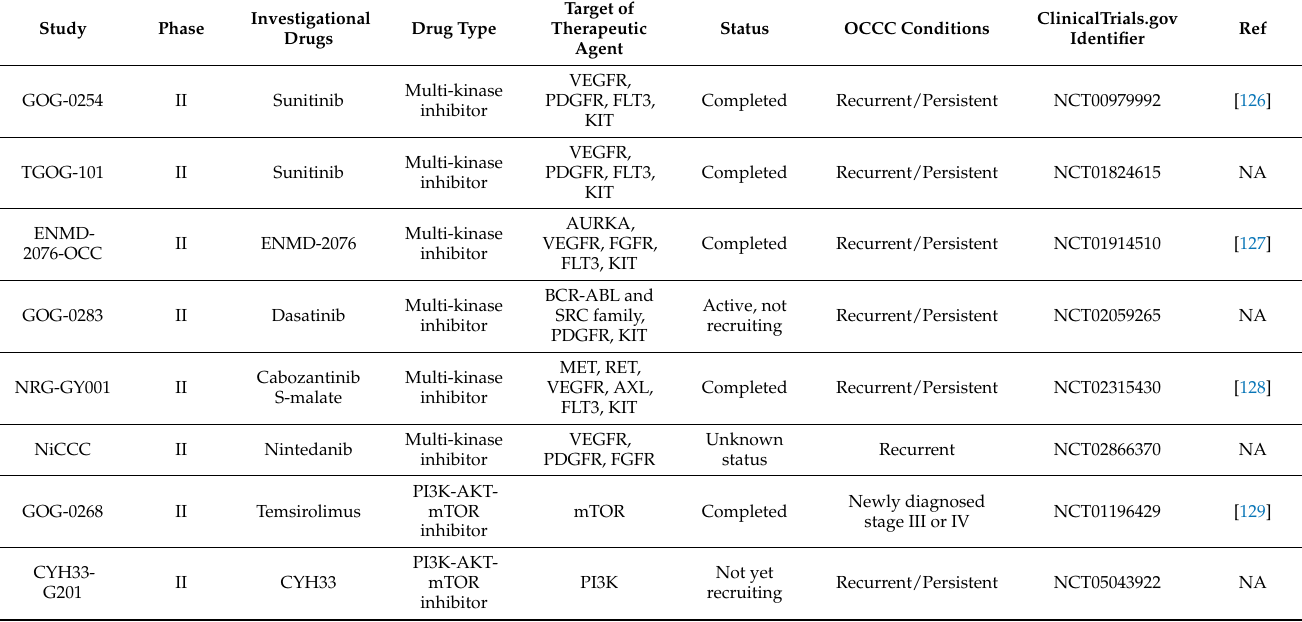
Table 2. Clinical trials of ovarian clear cell carcinoma using molecular targeted